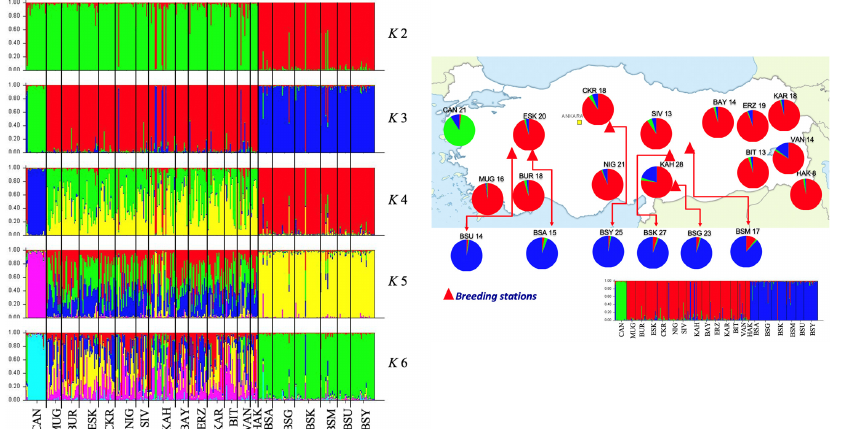
Figure 6. STRUCTURE assignment of 362 individual microsatellites for K = 2 to K = 6. Each individual genotype is represented by a vertical bar. Black lines separate the 20 different populations, 14 wild and six captive. The most likely number of clusters is K = 3. Besides, CAN chukars are clustered separately from other wild populations ( K = 3– K = 6). The sample size is shown above each respective pie